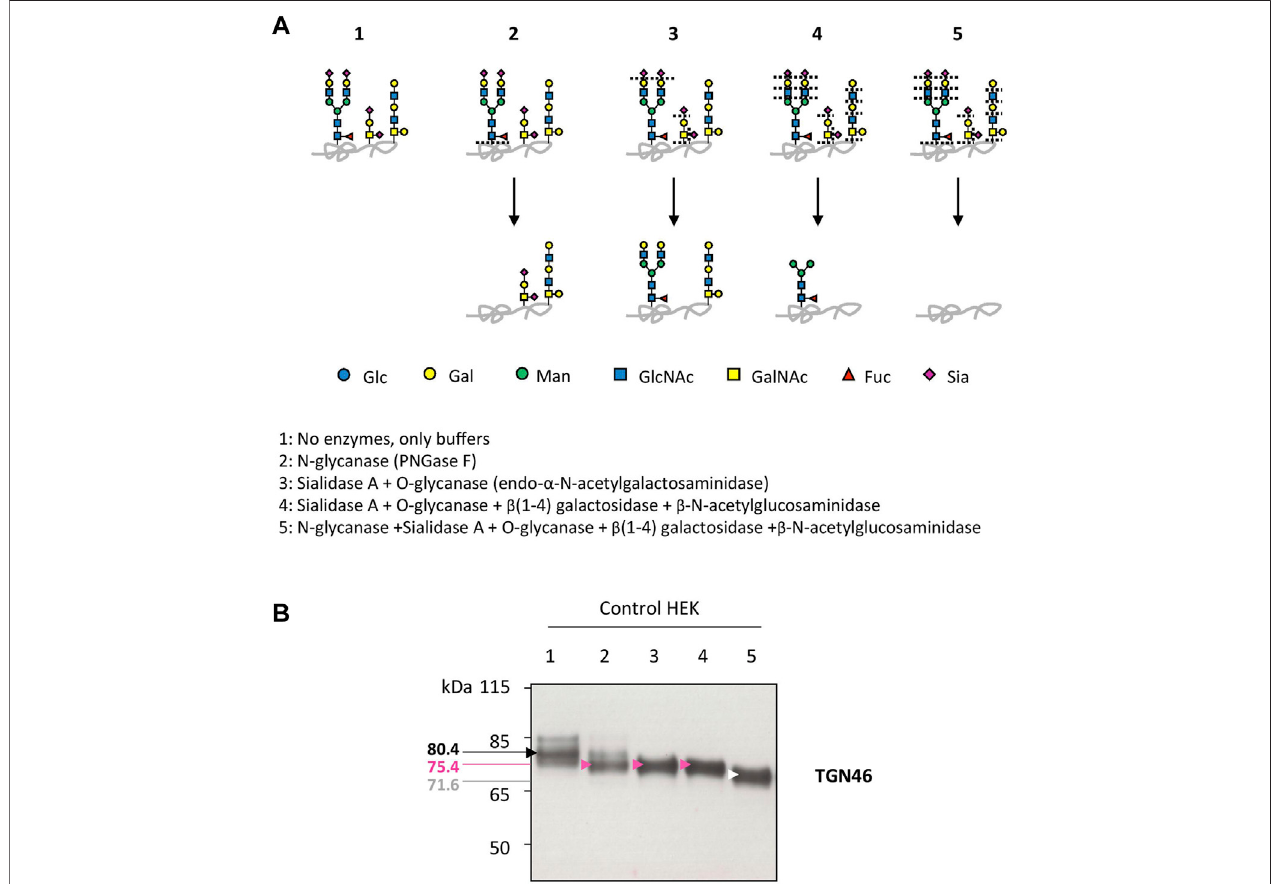
FIGURE 2 | Insights into the nature of TGN46 glycosylation sites. (A). Schematic representation of the N - and O -linked glycan structures resulting from the enzymatic deglycosylation conditions described in the legend to scheme (1 – 5). Speci fi c cutting sites are indicated with dashed lines. (B). Control HEK cell lysates were prepared for the different enzymatic digestionsfollowing guidelines and protocol provided by the manufacturer (see Material and Methods section). Then,samples were loaded onto SDS-PAGE and western-blot was incubated with TGN46 antibody. Black, pink, white and red arrows indicate different shifts in the migration of the major band within TGN46 electrophoretic pattern. Corresponding molecular weights are indicated on the left side of the western-blot. Gal, galactose; GalNAc, N -acetylgalactosamine; Glc, glucose; GlcNAc, N -acetylglucosamine; Fuc, fucose; Man, mannose and Sia, sialic acid ( n = 3)